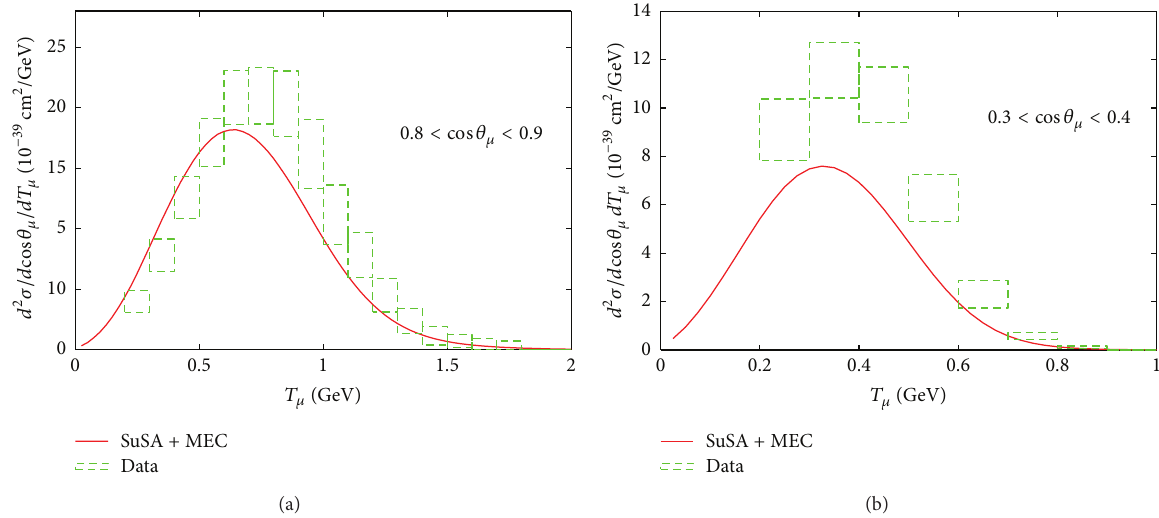
0.8 < cos 𝜃 𝜇 < 0.9